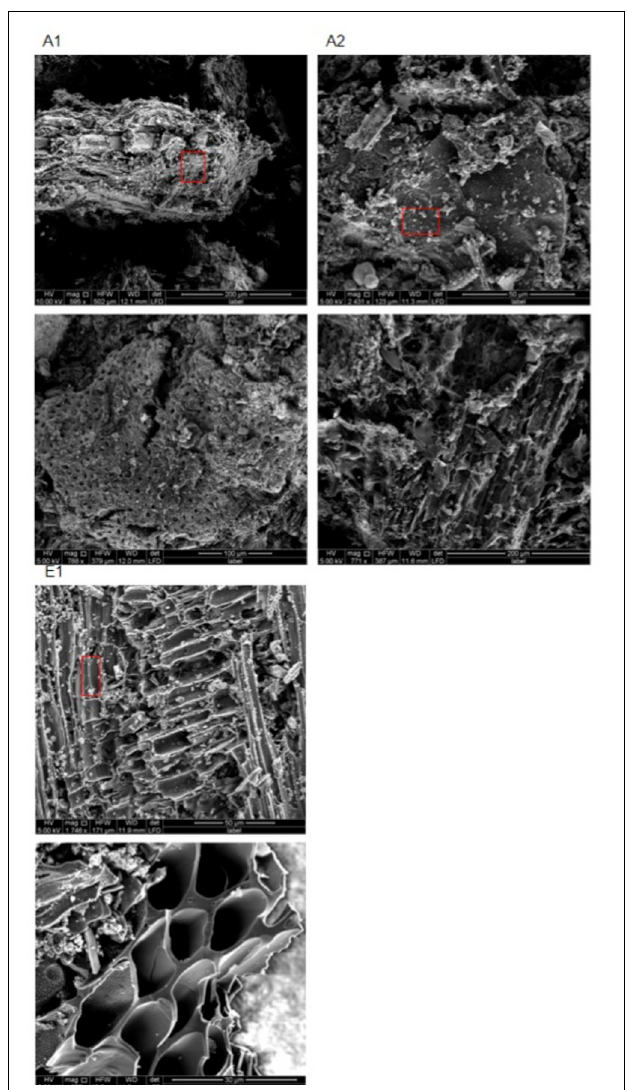
FIGURE 5 | Environmental scanning electron microscopy (ESEM) images of biochars A1 (2 top left), A2 (2 top right), and E1 (2 bottom left) at different magnifications (see figure bottom and white bar bottom right). All images were acquired with electron beam at 5 KV and a working distance between 11.9 and 12 mm. Red rectangles indicate the areas from which the EDX spectra in Figure 7 were